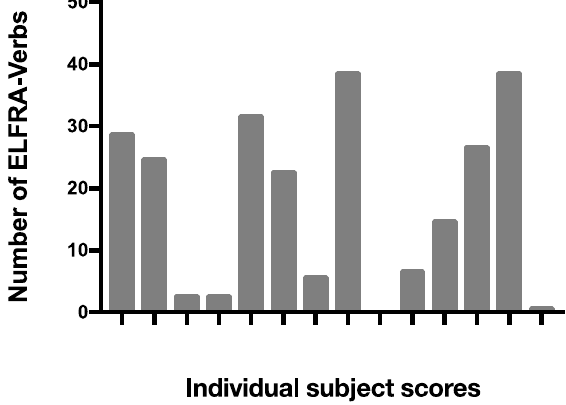
Figure 11. Infants’ number of spoken verbs at 24 months as reported by their parents.